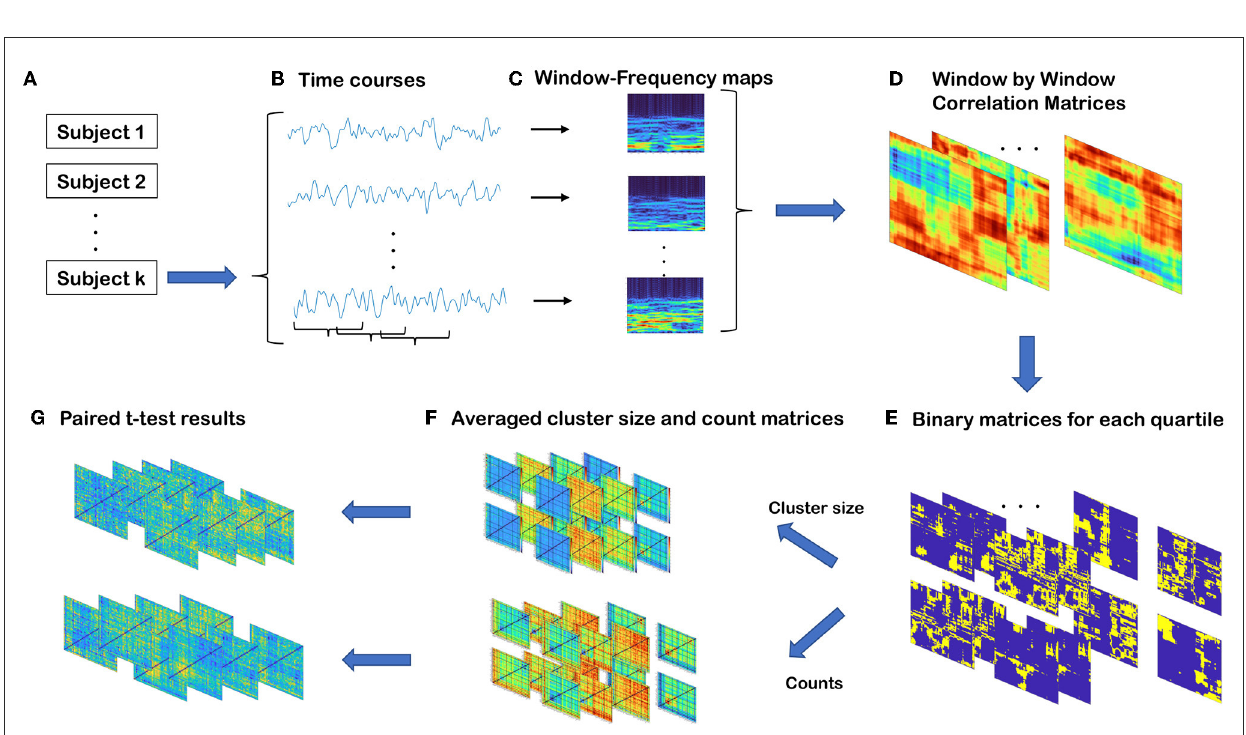
FIGURE2 Summary of steps involved in time-resolved spectral coupling analysis. (A) Three hundred fourteen subjects in total 151 (114 males, 37 females) SZ and 163 (117 males, 46 females) HC. (B) For each subject, there are 47 components and each of them is associated with a windowed time-course. (C) Power spectra of windowed time-courses. The sizes of the matrices are S by T where S is the half of window length and T is the number of windows. (D) Correlation matrices of windowed power spectra for all possible component pairs. The sizes of the matrices are T by T. (E) By collapsing all WW matrices for all subjects, global quartile values are computed. By using these quartile values, four binary matrices are defined for each WW matrix. The sizes of each matrix are the same as WW matrices. (F) Average cluster size and the average count of cells in each quartile. (G) Regression analysis results for each averaged count and average cluster size matrices in each quartile to examine the group